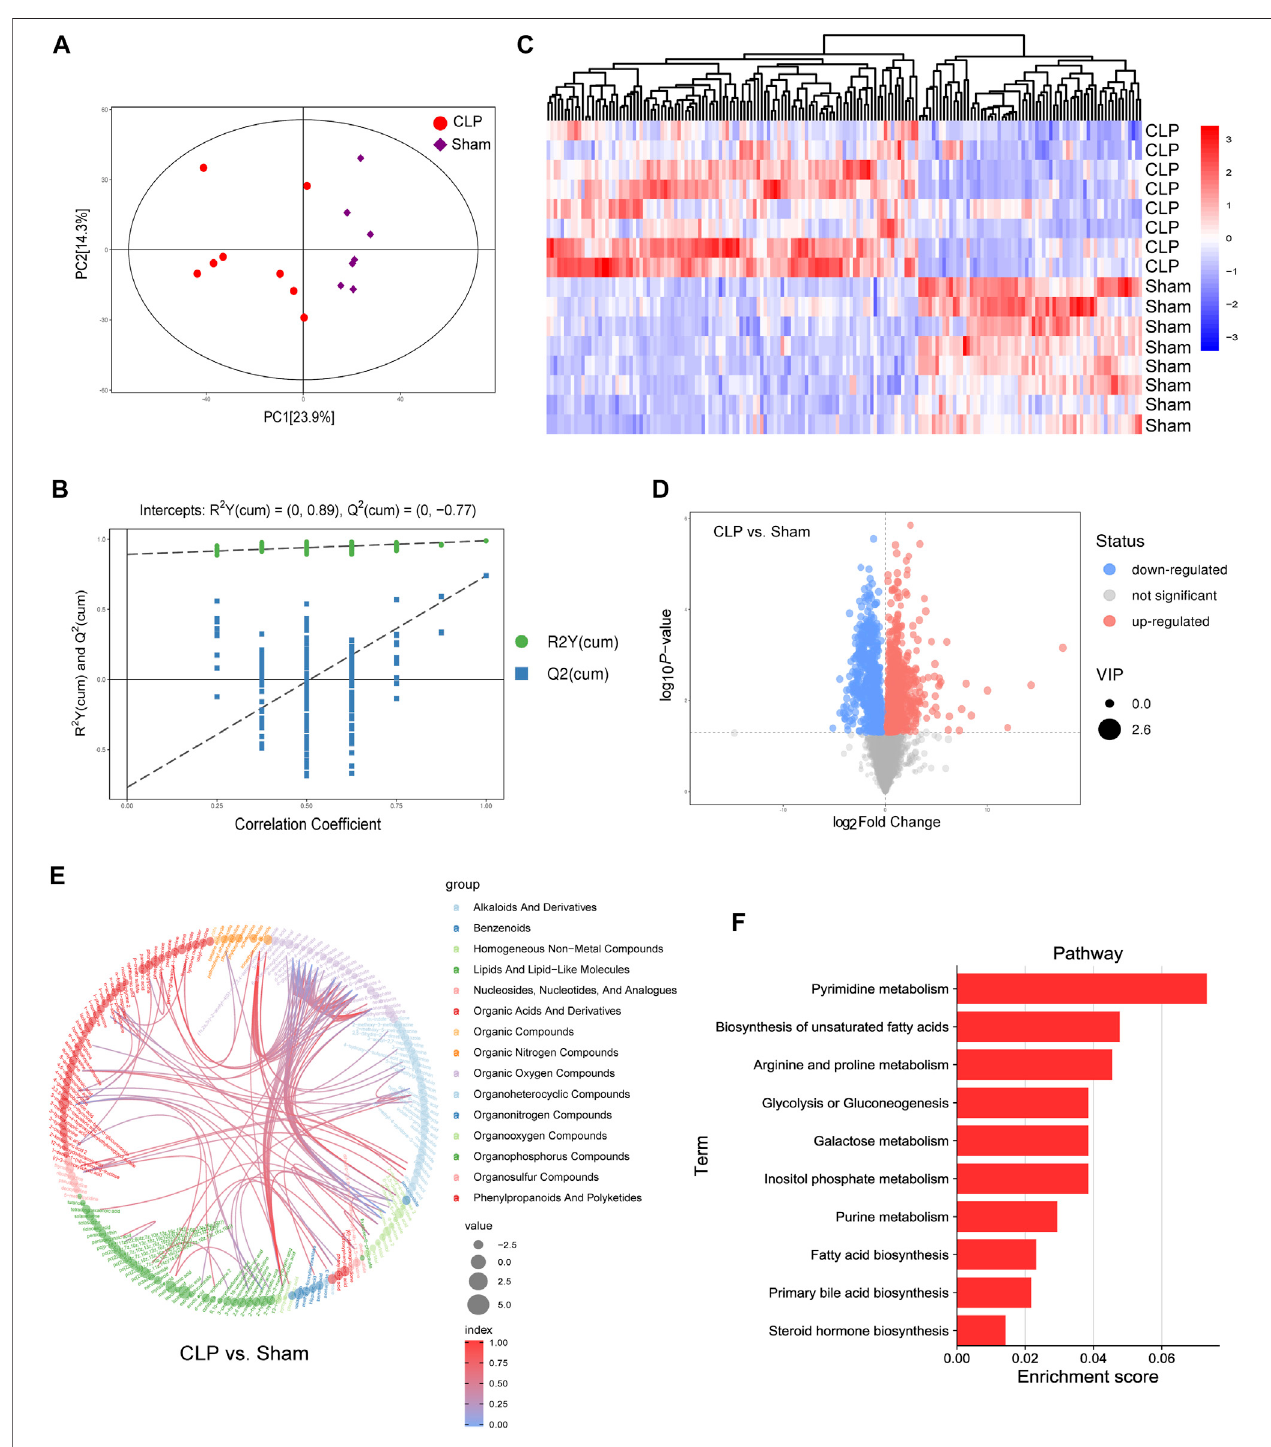
FIGURE8| Landscape ofthemetabolismpro fi le oftheheart following inCLP. (A) Principalcomponent analysis (PCA) scoreplot formetabolomics analysisin CLP andSham.OrangerepresentedCLP,andbluerepresent theSham. (B) PermutationtestoftheOPLS-DAmodelforCLPgroupvs.Shamgroup. (C) Heatmapanalyzed using TBtools showing the signi fi cantly changed metabolites in CLP rats and the Sham control. (D) Volcano plot. (E,F) Chord and histogram and metabolic pathway enrichment analysis identi fi ed in CLP rats and the Sham control. The different color depths of circles represent the p value of pathway enrichment analysis.